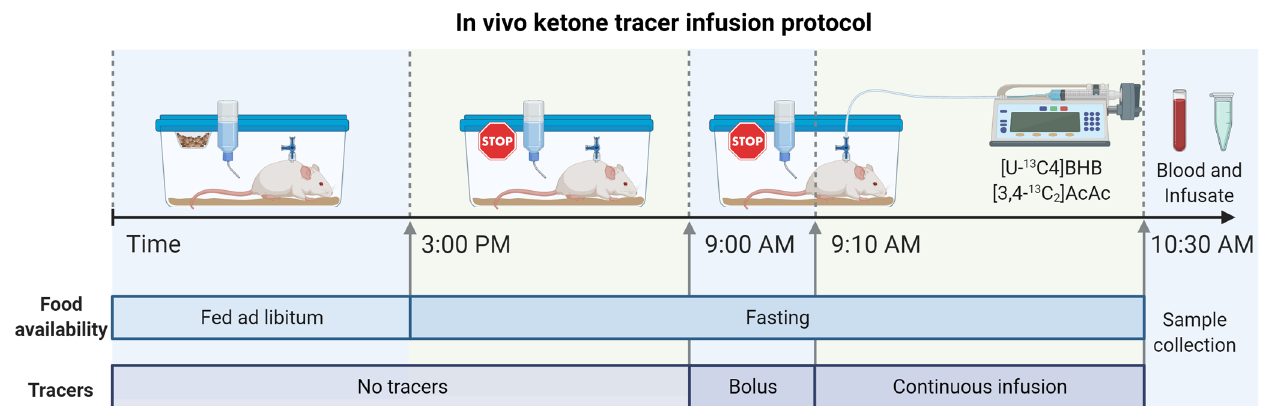
Figure 2. In vivo double ketone tracer infusion protocol in fasted mice. Tracers were administered as a 10-min bolus and 80-min continuous infusion to rapidly achieve and maintain steady-state enrichment. At the conclusion of the experiment, blood and the remaining infusate samples were collected for analysis.